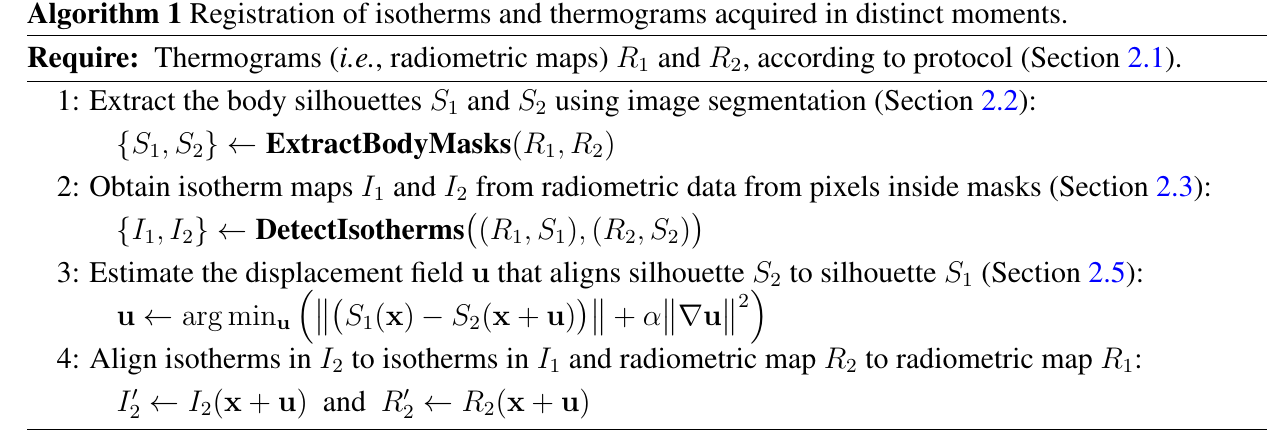
Algorithm 1 Registration of isotherms and thermograms acquired in distinct moments.